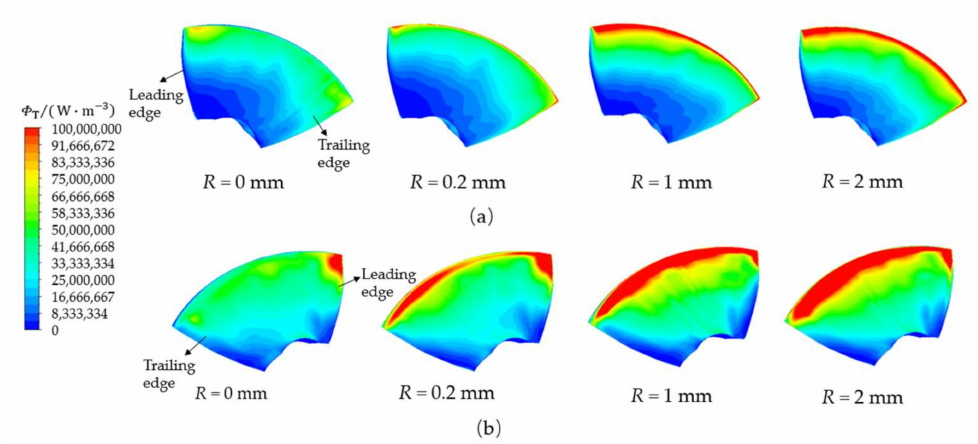
Figure 19. Dissipation rate distribution on blade surface under turbine condition. ( a ) Pressure side. ( b ) Suction side.